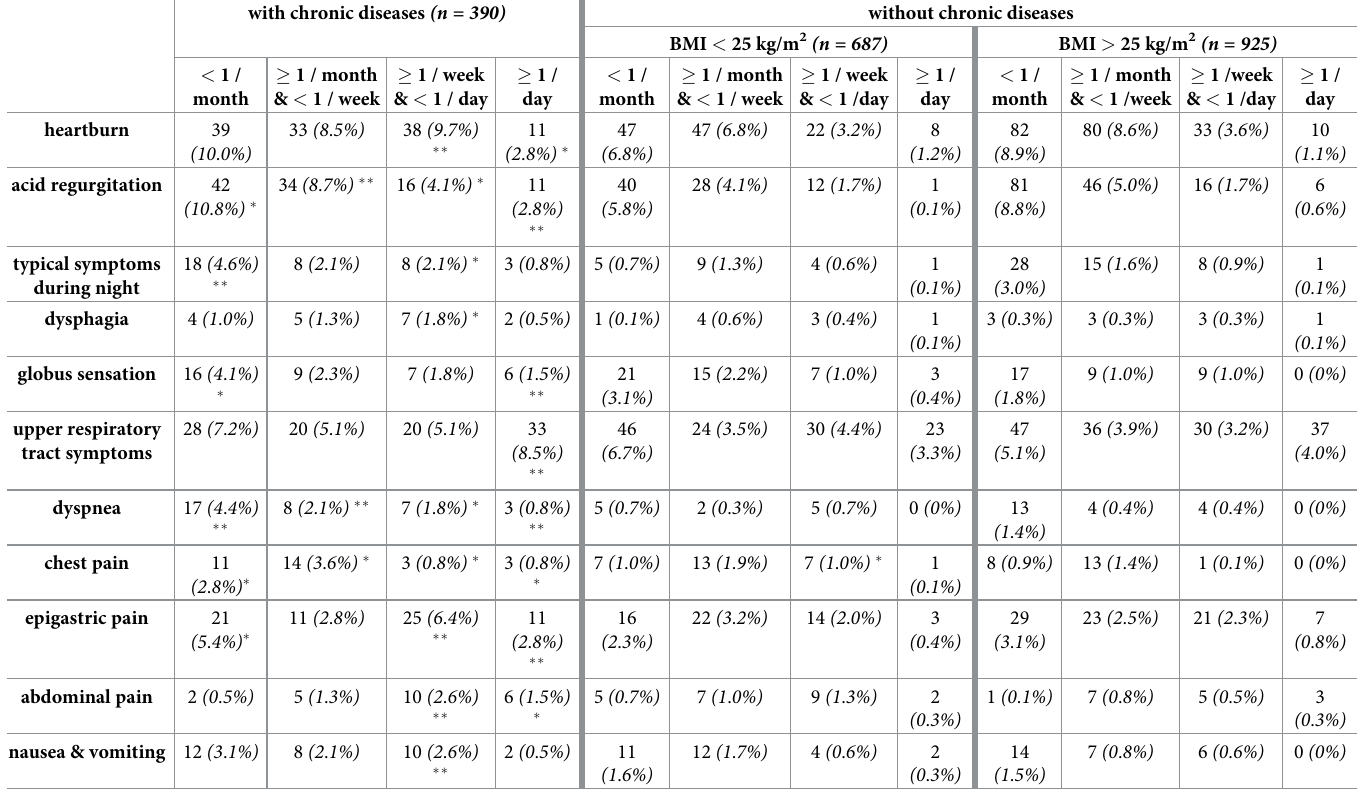
Table 5. The effect of coexisting, chronic diseases (including obesity) on the prevalence of GERD-related symptoms. with chronic diseases (n = 390) without chronic